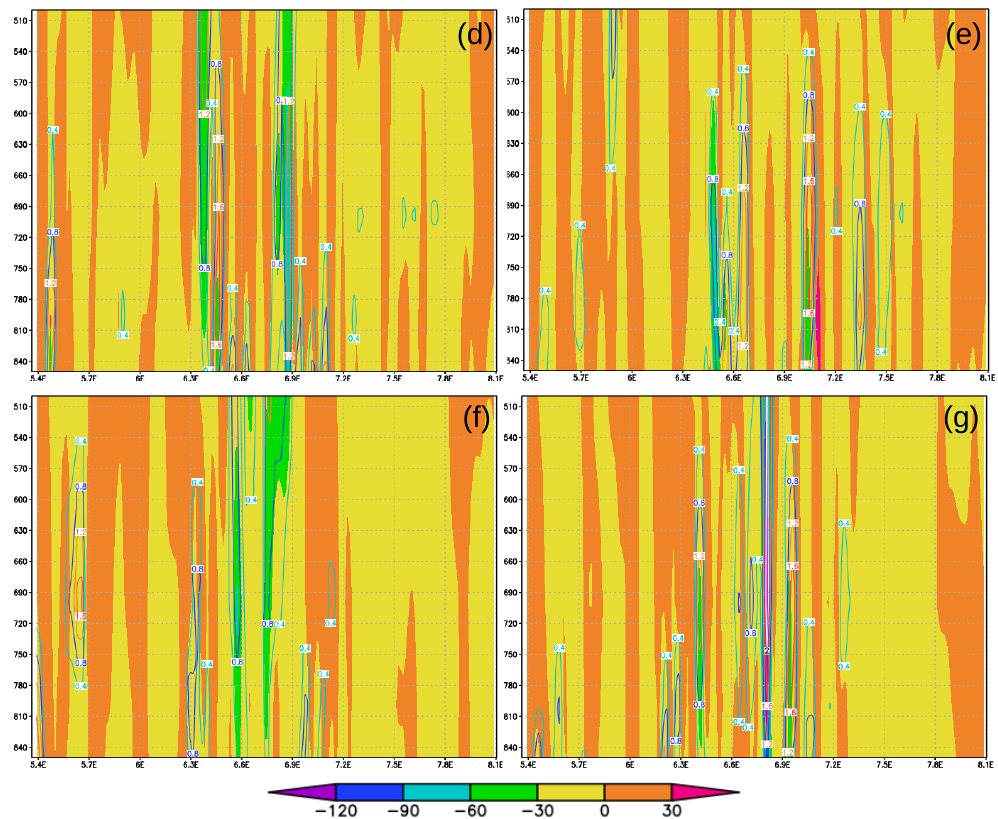
Figure 14. Vertical velocity (Pa s − 1 , shaded contours) and cloud water mixing ratio (g kg − 1 , line contours) cross sections, taken at 43.65 ◦ N, and shown in panel ( a ), at 19 UTC, 3 October 2015 for ( b ) W_GFS, ( c ) W_GFS_SST, ( d ) W_ECM, ( e ) W_ECM_SST, ( f ) W_GFSANL and ( g ) W_GFSANL_SST